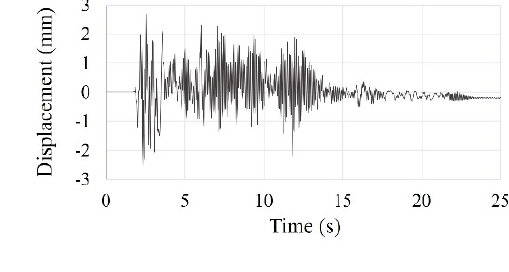
Figure 13. Time history curve of the SDOF model by scaled El Centro earthquake vibration test: ( a ) first test; ( b ) second test; ( c ) third test; ( d ) fourth test; ( e ) five test; ( f ) overlapping entire tests. Figure 14. Cont